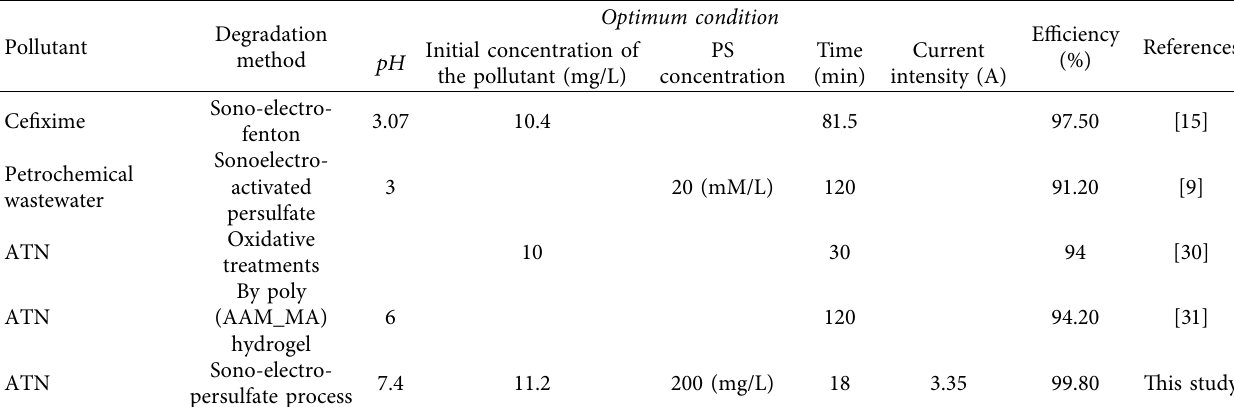
Figure 5: 3D graphs of ANFIS prediction showing the interaction efects of input variables on the ATN degradation rate. Table 2: Comparative evaluation of the results for this study with previous